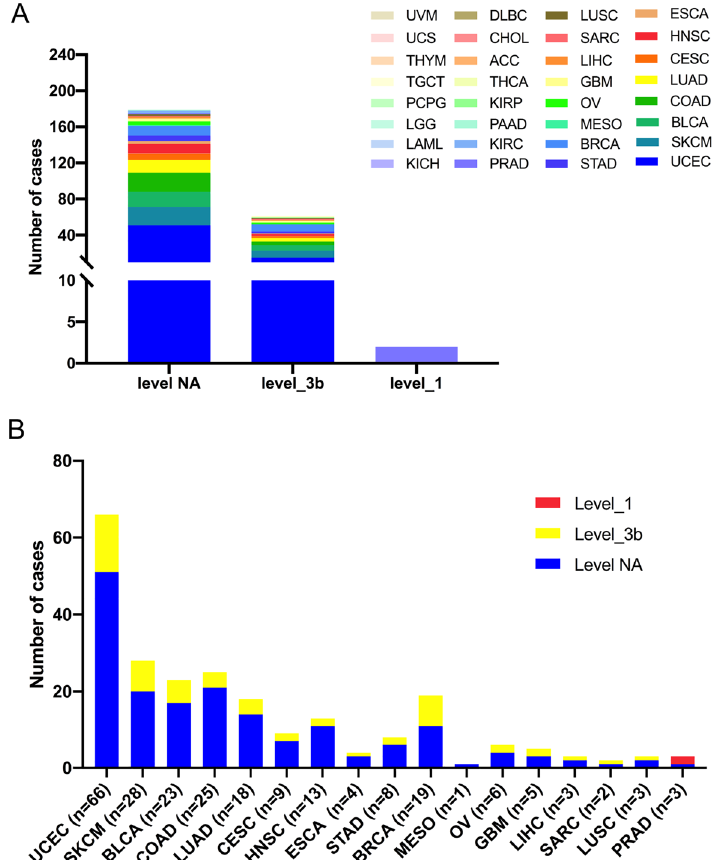
Figure 5. The classification of BRIP1 mutations according to potential effects of targeted therapy. ( A ) Based on the clinical therapy implications as annotated in OncoKB, BRIP1 mutation categorization is performed. ( B ) Distribution of BRIP1 mutations by therapy implications in pan cancer and in the top 17 cancer